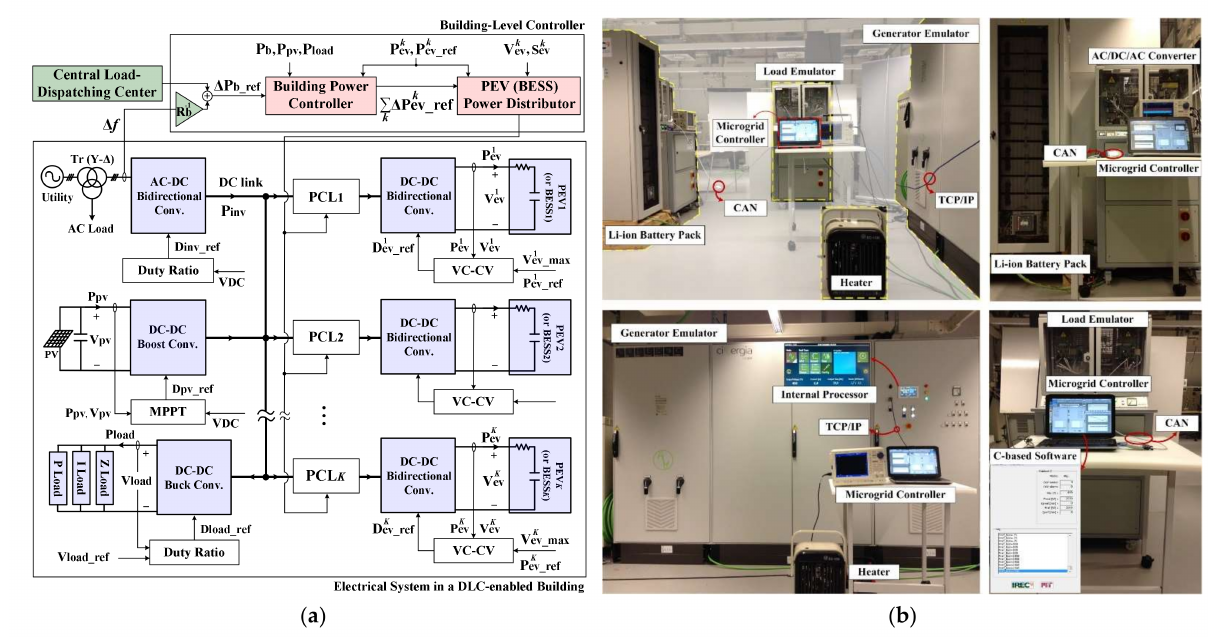
Figure 13. ( a ) A schematic of a new electrical system inside a commercial building and ( b ) the experimental setup of an MG including a generator emulator, a battery pack, and a load emulator.